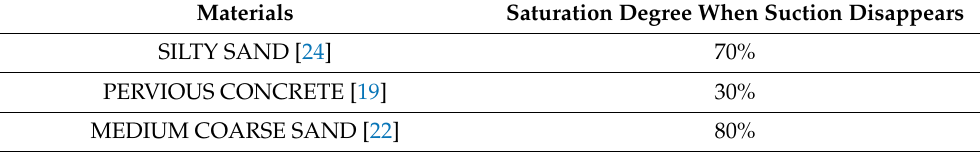
Figure 2. A possible framework for porous media under wetting [19], in the Saturation Degree vs. Suction plot: the arrow pointing right indicates that van Genuchten’s parameter “a” increases, together with the Air Entry Value; the arrow pointing down indicates that θ 0 can be lower than θ s . Table 1. Values of the saturation degree when suction practically disappears for porous materials under wetting.